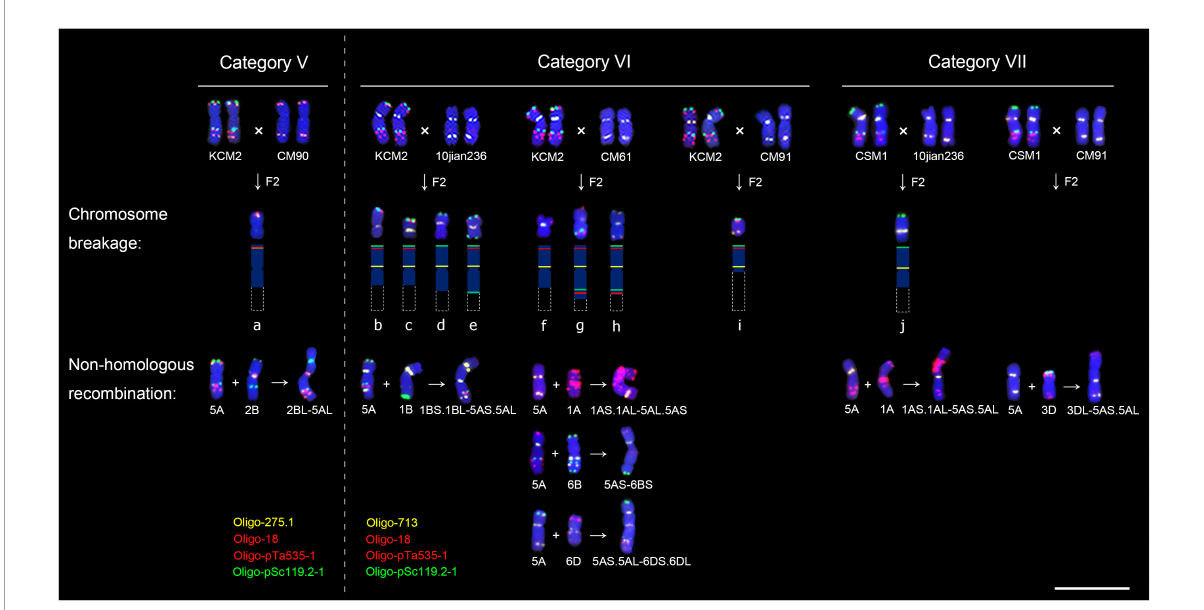
FIGURE5 Fluorescence in situ hybridization signal patterns of the broken 5A chromosomes and non-homologous recombination chromosomes. “ × ” indicates hybridization. “F2” indicates F 2 generation. “+” indicates translocation. Dotted boxes indicates missing parts of chromosomes. Scale bar, 20 µ m.